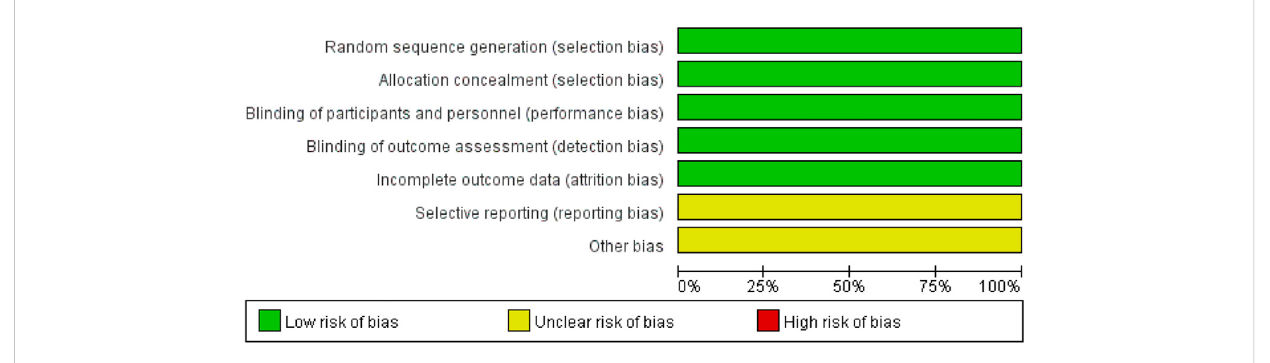
FIGURE 2 Risk of bias graph.